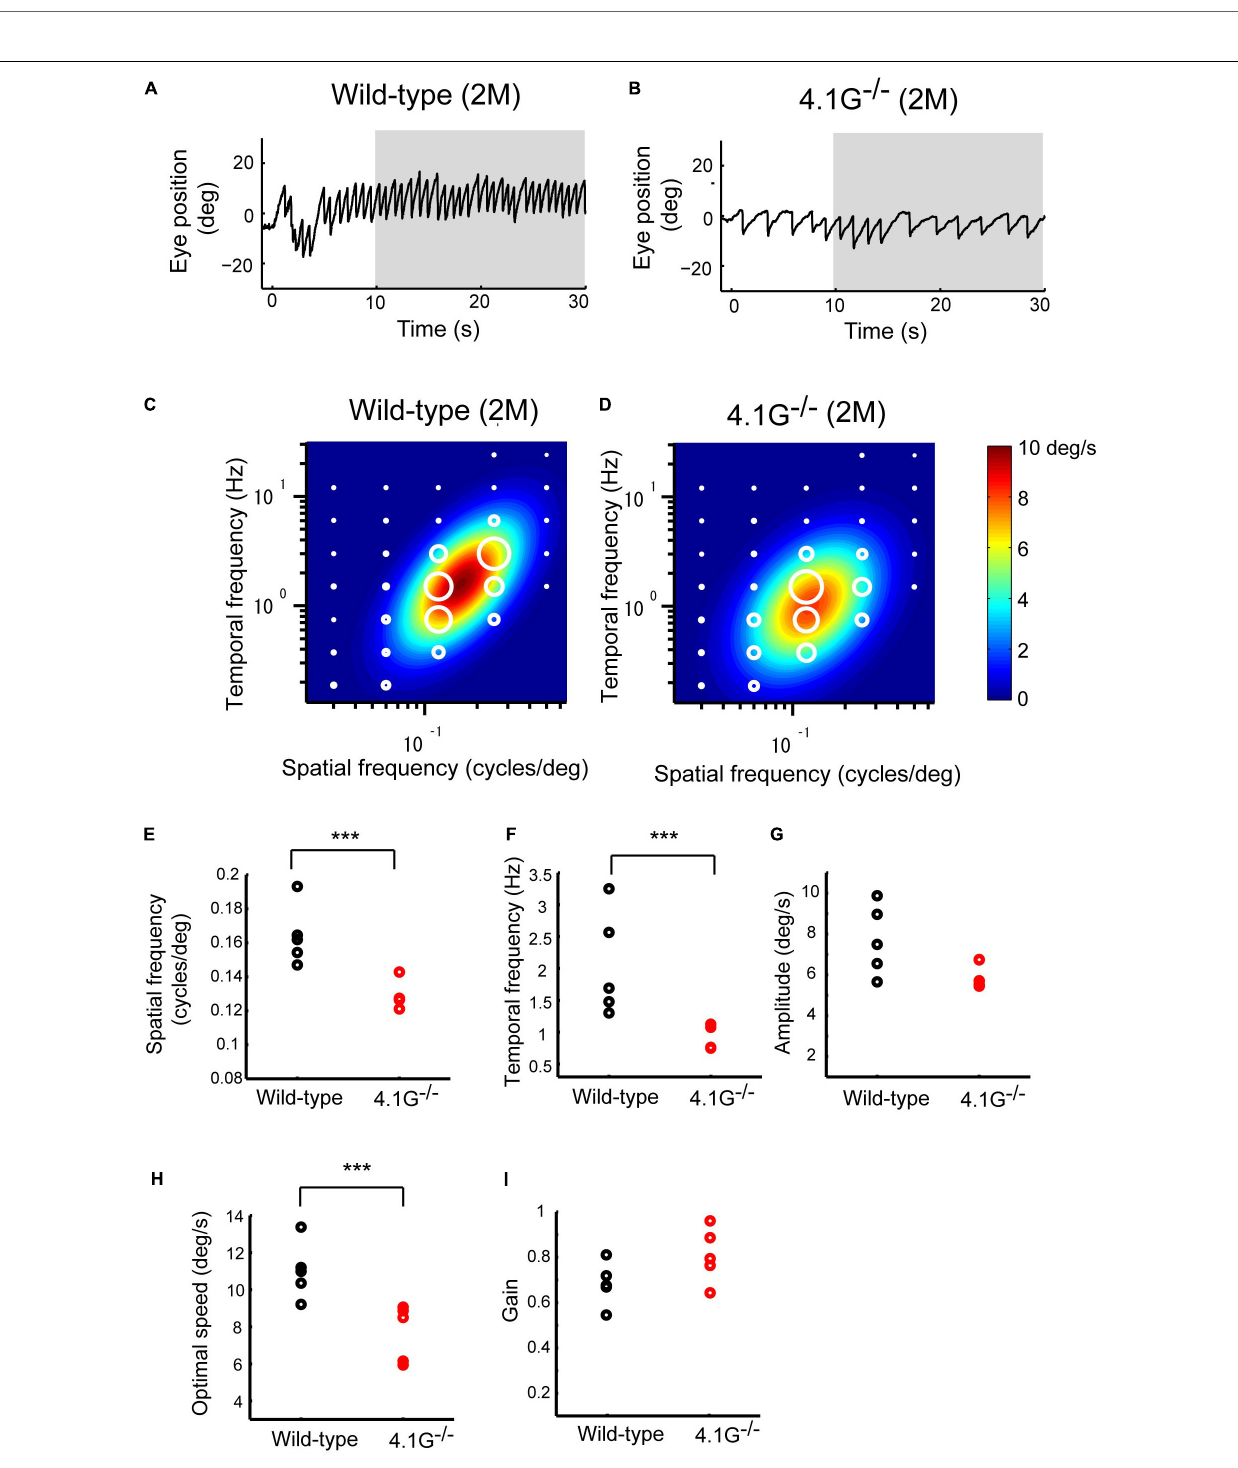
Frontiers in Neuroscience |